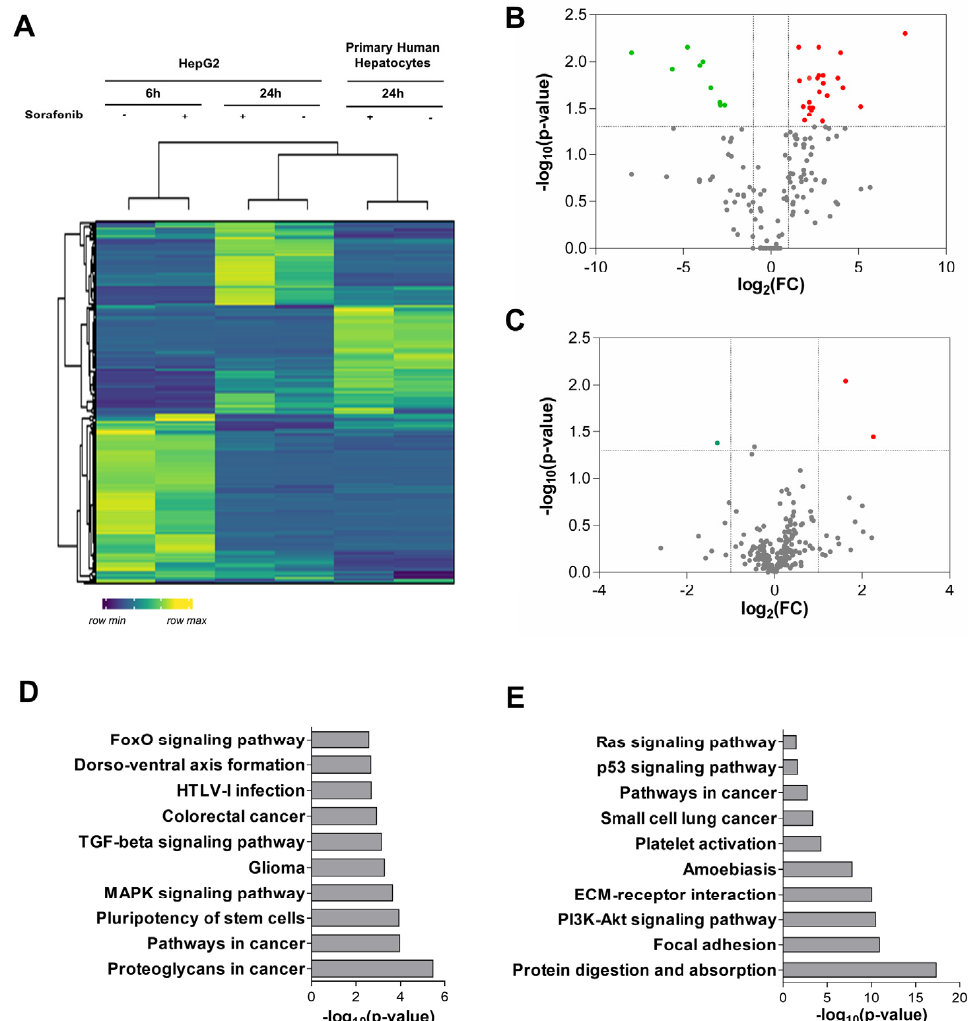
Figure 1. miRNA pattern induced in primary human hepatocytes. ( A ) Heatmap of miRNA expression in HepG2 cell lysates at 6 and 24 h of treatment, compared to primary hepatocyte expression profile after Sorafenib (24 h) (n = 3). ( B ) Volcano plot of miRNA expression analysis in the HepG2 cells compared to primary human hepatocytes (non-treated) (n = 3). Up-regulated miRNAs are shown in red and down-regulated miRNAs are shown in green. ( C ) Volcano plot of differentially expressed miRNAs in primary human hepatocytes treated with Sorafenib (24 h) (n = 3). ( D ) Top 10 most significant KEGG pathways enriched in targets of miRNAs differentially expressed in HepG2 cells. ( E ) Top 10 most significant KEGG pathways enriched in targets of miRNAs differentially expressed in treated primary human